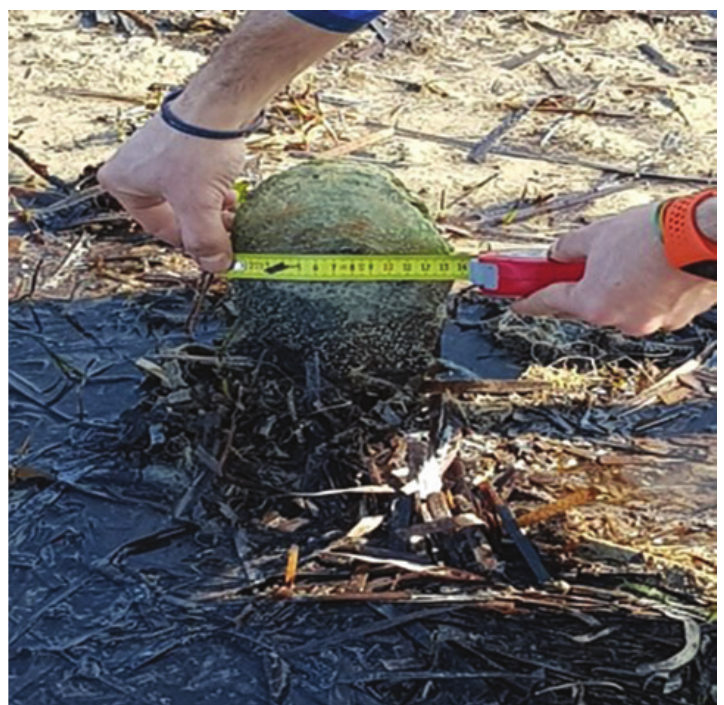
Figure 4. Biometric measurements of Pinna nobilis . Due to an exceptional low-tide day, some specimens were partially